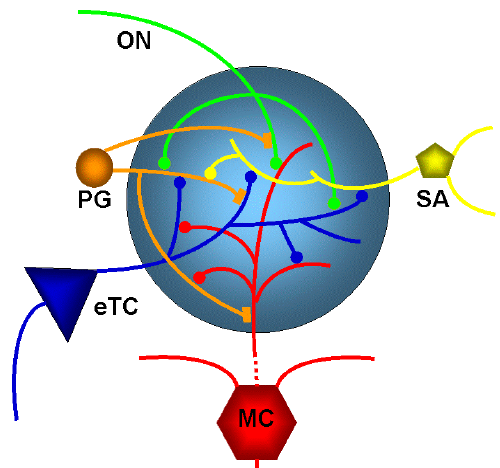
Figure 2. Diagram of the glomerular network. Olfactory nerve (ON) afferents enter the main olfactory bulb through the olfactory nerve laver to synapse with periglomerular cells (PG), mitral cells (MC) and tufted cells (of which only external ones, eTCs are shown) within the glomerular layer. Periglomerular cells inhibit olfactory nerve terminals, external tufted cells and mitral cells. Short Axon (SA) cell axons receive synaptic input from external tufted cells and form extensive interconnections between glomeruli, making glutamate synapses with periglomerular cells, while mitral cell apical dendrites convey sensory information to deeper layers of the main olfactory bulb. Mitral cells and tufted cells form dendrodenritic synapses with periglomerular